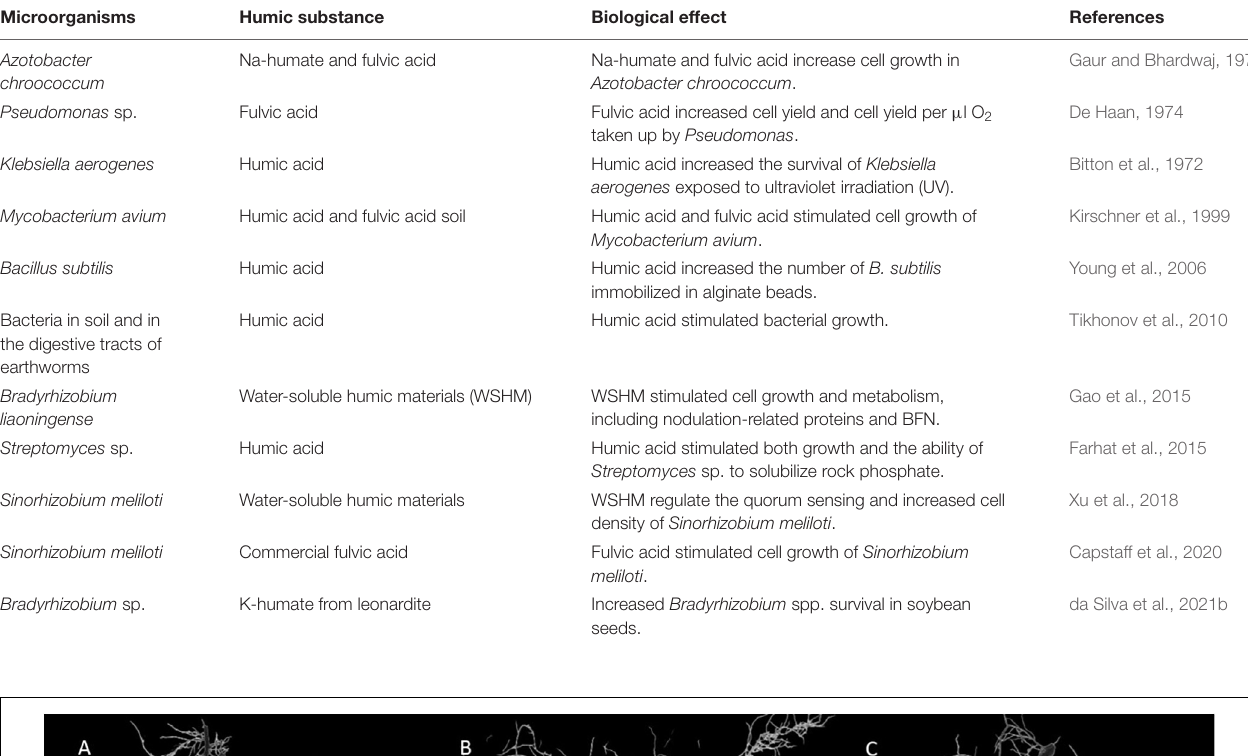
TABLE 1 | Studies examining bacteria associated with humic substances.